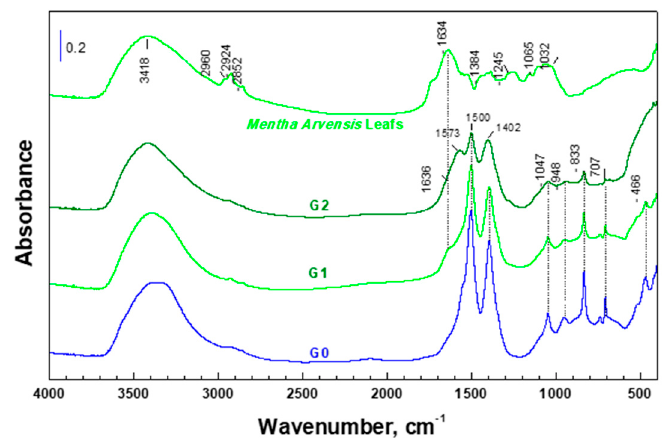
Figure 7. Infrared spectra of plant-mediated ZnO samples.